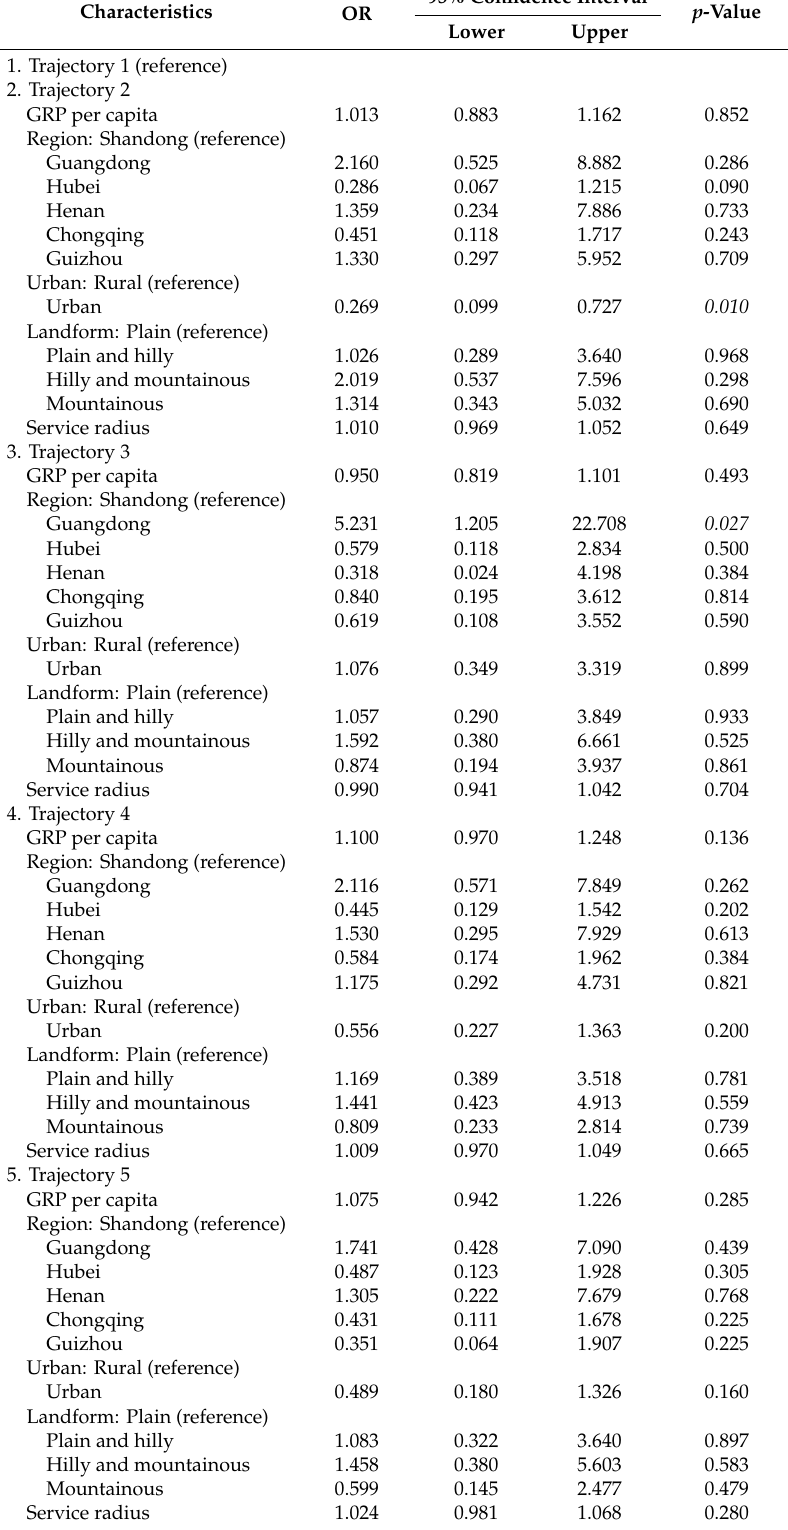
Table 6. Time-stable characteristics associated with di ff erent trajectories of basic public health services ( n =